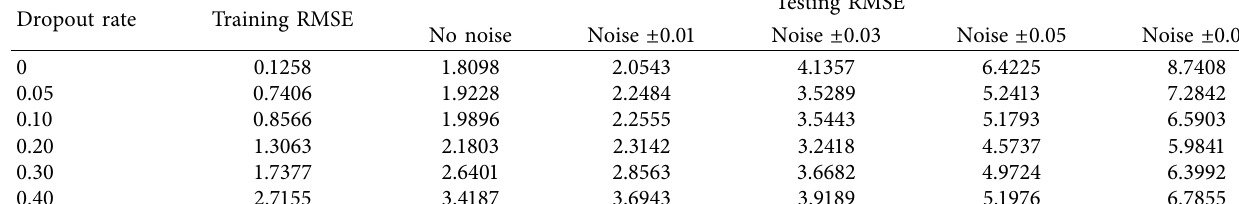
Table 2: Training and testing RMSE of LSTM prediction model trained by 100,000 epochs with diferent dropout rates. Dropout rate